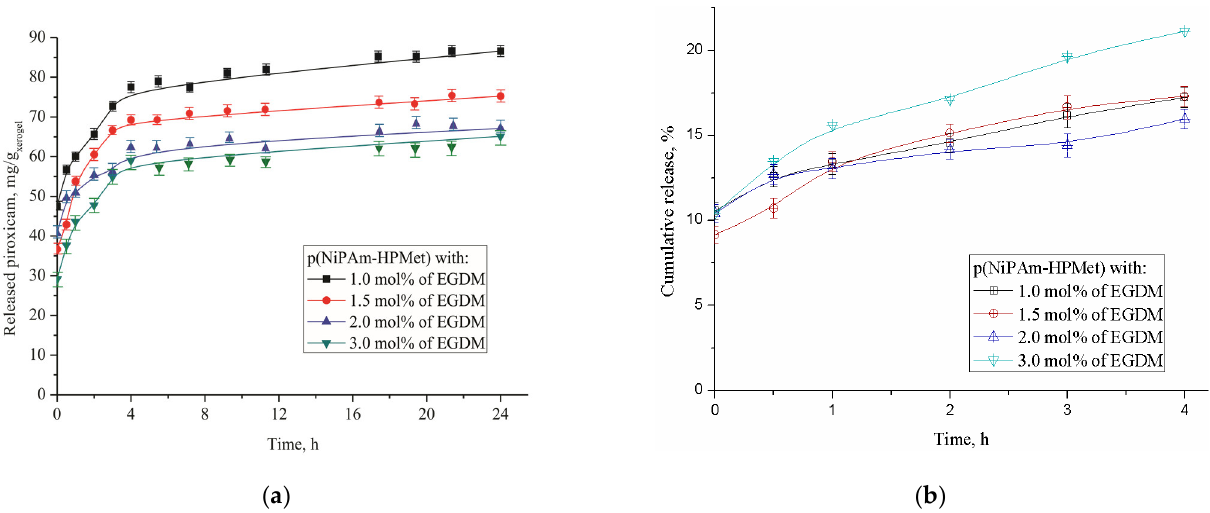
Figure 7. In vitro cumulative release of piroxicam from series of p(NiPAm-HPMet) hydrogels at 37 °C and pH 7.4: ( a ) in mg/g xerocel during 24 h; ( b ) in percentages during first 4 h. Error bars represent the standard deviation of the means of three replicates.